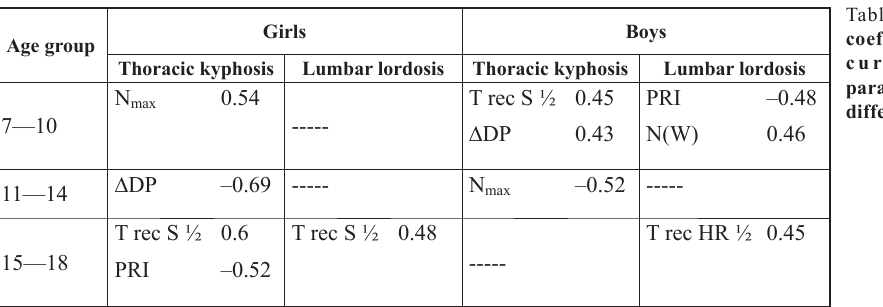
Table 2. Correlation (Spearman’s coefficient) between spine sagittal curves and cardiovascular parameters among boys and girls of different age groups (p <